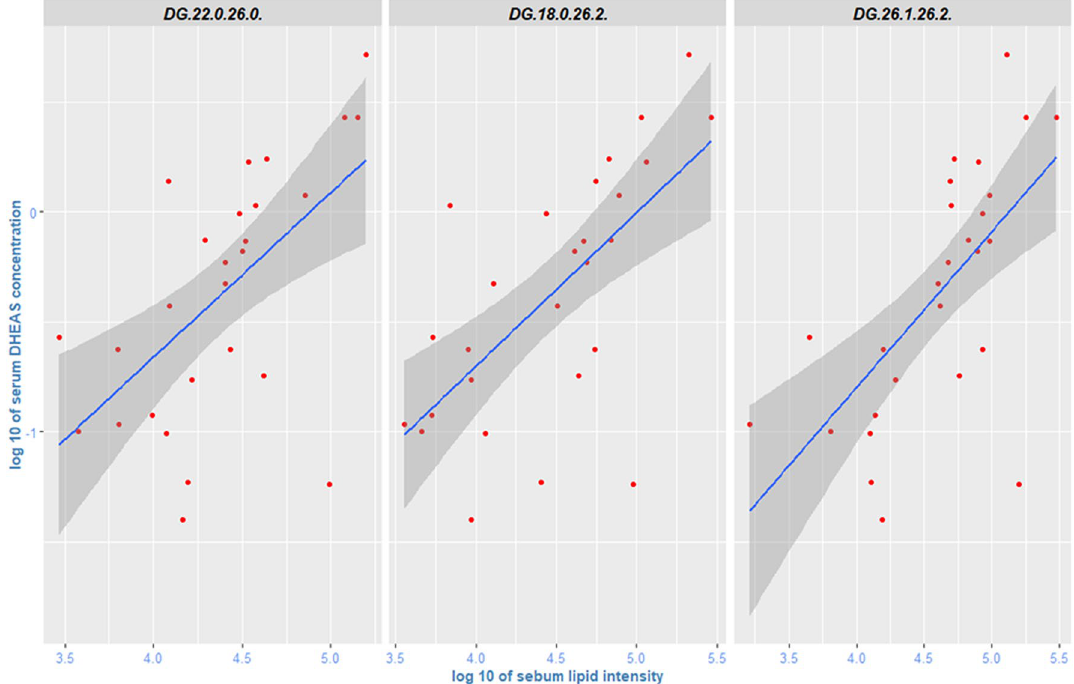
Figure 3. Pairwise correlations between serum DHEAS and sebum diglycerides (COVID-19 Positive study